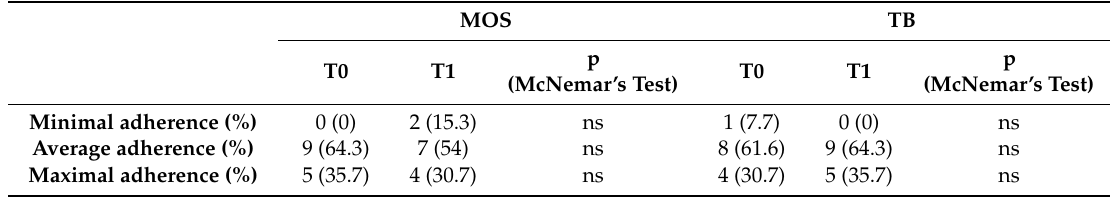
Table 7. International Physical Activity Questionnaire Table 6. Prevención con Dieta Mediterránea (PREDIMED) questionnaire.